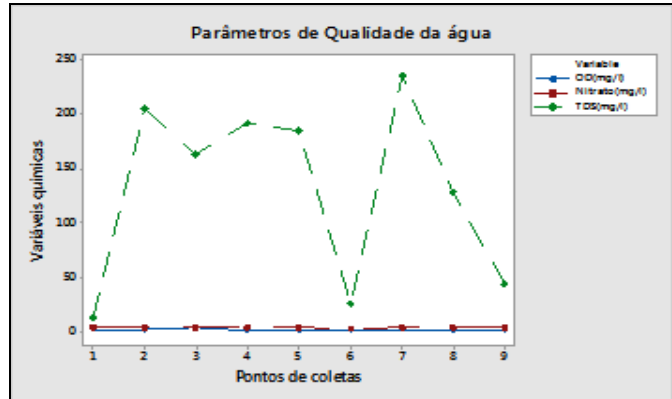
Figura 15: Parâmetros de qualidade da água. Fonte: Autores,